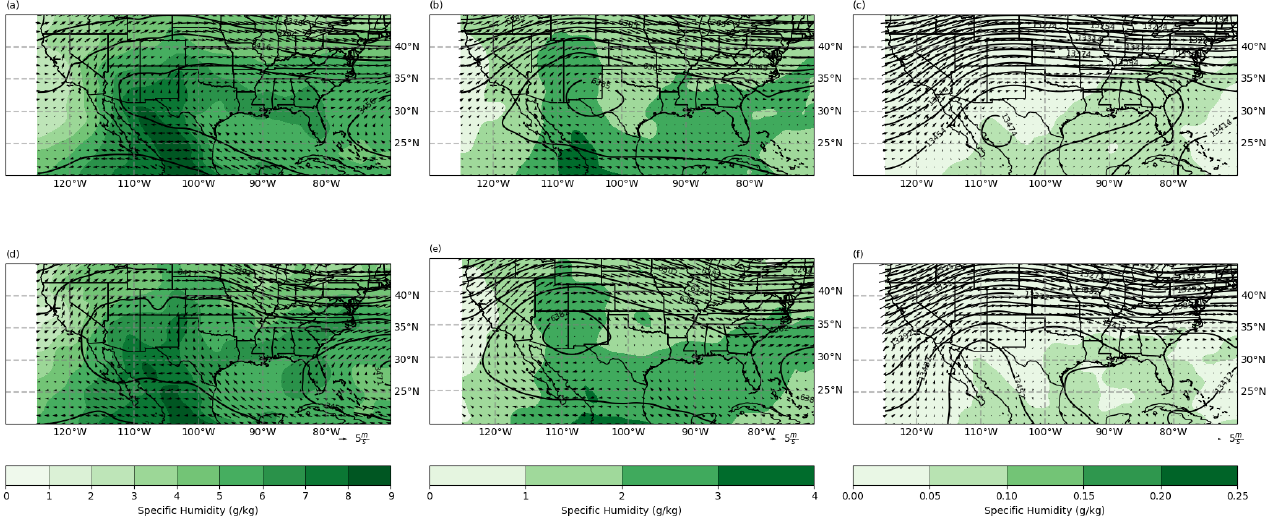
Figure 12. Composite of the atmospheric conditions at 700, 500, and 200 mb (left, central, and right panels) for the MCS trajectory 2 in the Band A ( a – c ) and B ( d – f ), respectively. Vectors are winds (m/s), contours are geopotential height (m), and green shading is specific humidity